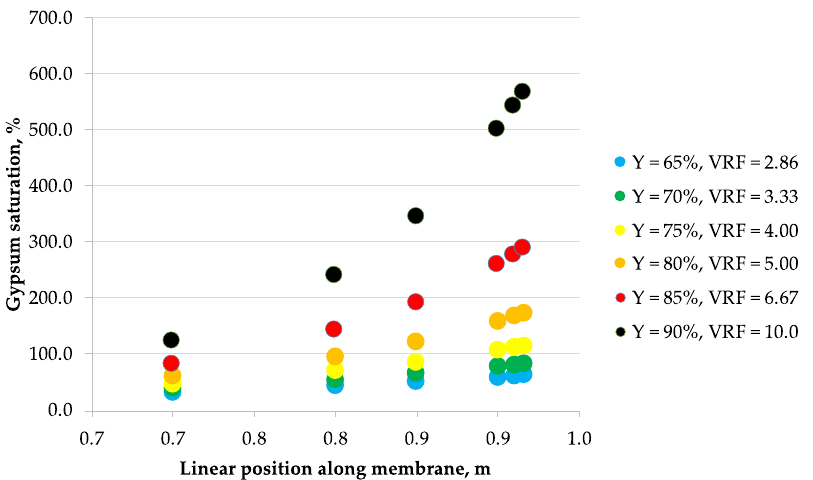
Figure 3. Saturation vs. position along the membrane for mine water B (33.2 g / L as Cl − , 0.937 g / L as SO 4 2 − , 19.5 g / L as Na + , 0.990 g / L as Mg 2 + , 0.771 g / L as Ca 2 + ) and NF270 nanofiltration membrane.